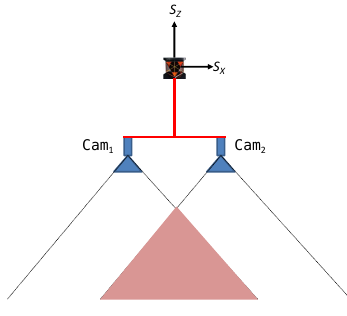
Figure 2: The “essence” of the geometry measurement: A cal- ibrated T-shaped rig consisting of a calibrated stereo configura- tion and a 360 ◦ prism. The calibration includes interior camera parameters and the relative orientation between Cam 1 , Cam 2 , and the prism. The scanner coordinate system ( S X , S Y , S Z ) is co- located with the prism center. S X is aligned with the axis of the stereo rig, and S Z coincides with the upright pole of the